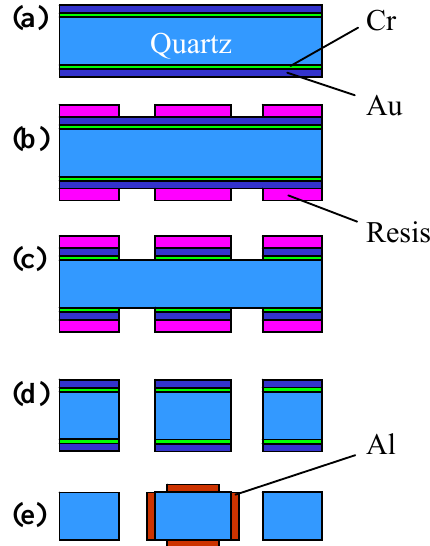
9. Cross-sectional scheme for the fabrication of the quartz